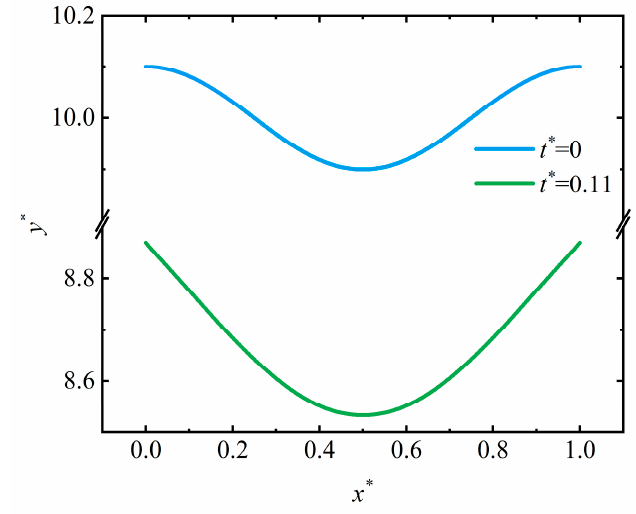
Figure 14. Surface morphology evolution process when A ∗ = 0.1 and σ A = 19 MPa.